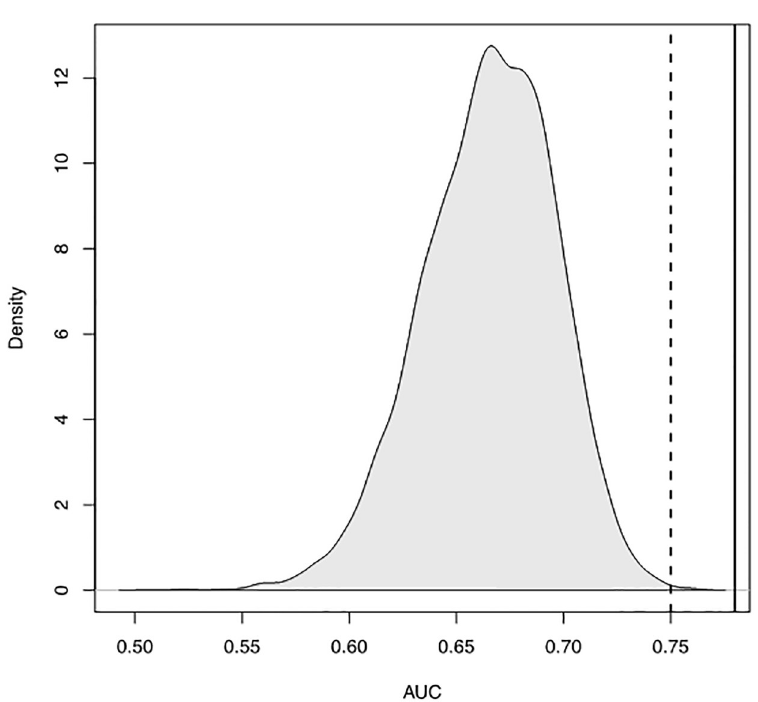
Fig 5. Area under the curve (AUC) obtained when classifying bacterial protective antigens (BPAs) from non- BPAs using a logistic regression classifier comprised of ten features from the dataset BPAD200. Ten features were selected randomly from the entire BPAD200 dataset (each feature was scaled between -1 and 1) and leave tenth out cross validation (LTOCV) with a logistic regression classifier was performed. This was repeated 10,000 times to obtain a frequency distribution. The dotted vertical line represents the AUC obtained through LTOCV when using the top ten features described previously in Heinson et al[16] with a logistic regression classifier. The solid vertical line is the AUC obtained from LTOCV using ten features derived from GBFE specifically of logistic